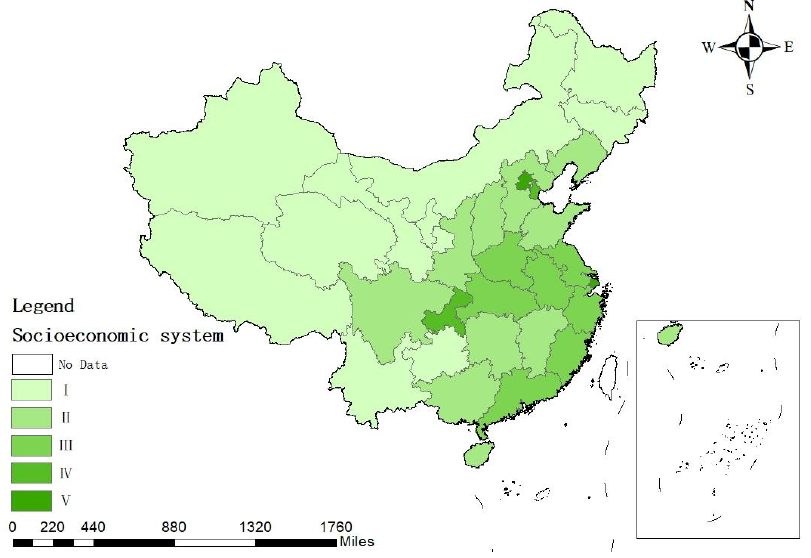
Figure 4. Assessment results of China ’ s socio-economic subsystem.